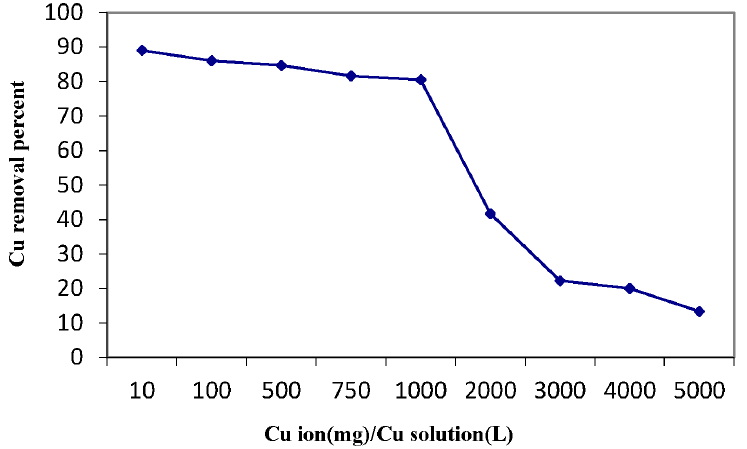
Figure 11. Effect of initial copper ion concentration on the copper sorption process using MANSG (time = 90 min; amount of MANSG = 0.25 g; agitation speed = 200 rpm; solution volume = 25 mL; pH = 7).